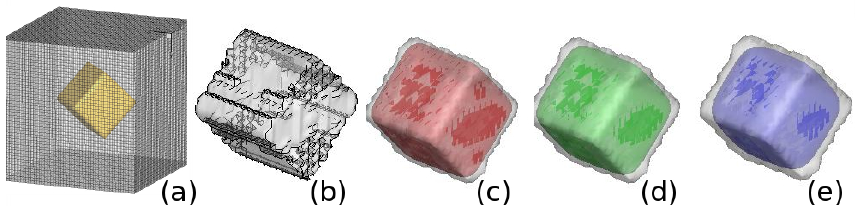
∆ L 1 for four N smoothing levels: ( b ) N = 0; ( c ) N = 16; ∆ X = 2